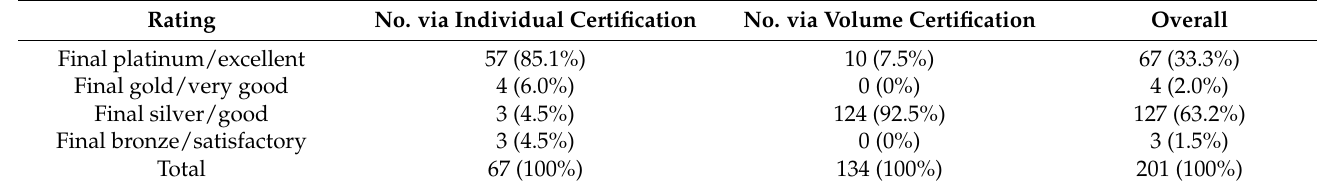
Table 2. Breakdowns of certifications by pathways and ratings (N =